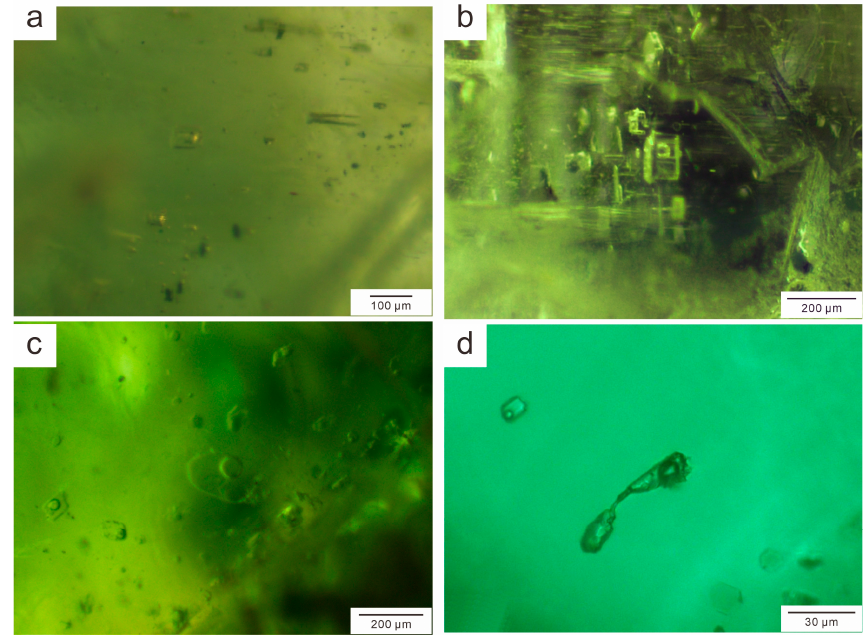
Figure 6. ( a ) Paralleling rectangular fluid inclusions in emerald (KAM-24); ( b ) Rectangular fluid inclusions in emerald (KAM-34); ( c ) Hexagonal fluid inclusions in emerald (KAM-44); ( d ) Necked- down, irregularly shaped fluid inclusion in emerald (KAM-44).